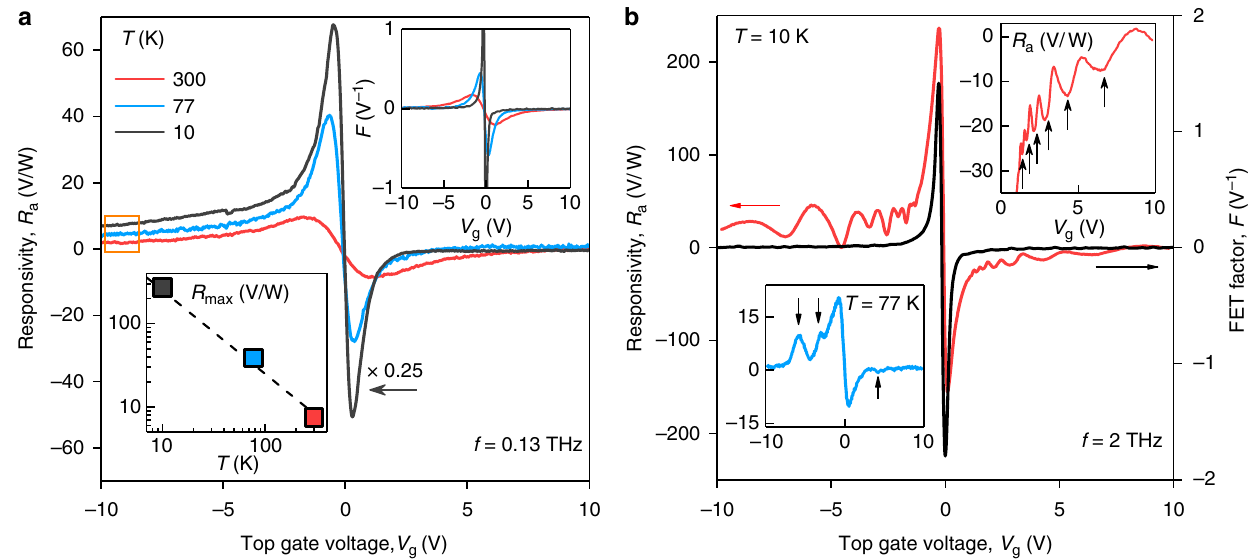
Fig. 2 Plasmon-assisted THz photodetection. a Responsivity measured at f = 130 GHz and three representative temperatures. Orange rectangle highlights an offset stemming from the recti fi cation of incident radiation at the p-n junction between the p-doped graphene channel and the n-doped area near the contact. Upper inset: FET-factor F as a function of V g at the same T . Lower inset: maximum R a as a function of T . b Gate dependence of responsivity recorded under 2 THz radiation. The upper inset shows a zoomed-in region of the photovoltage for electron doping. Resonances are indicated by black arrows. Lower inset: resonant responsivity at liquid-nitrogen